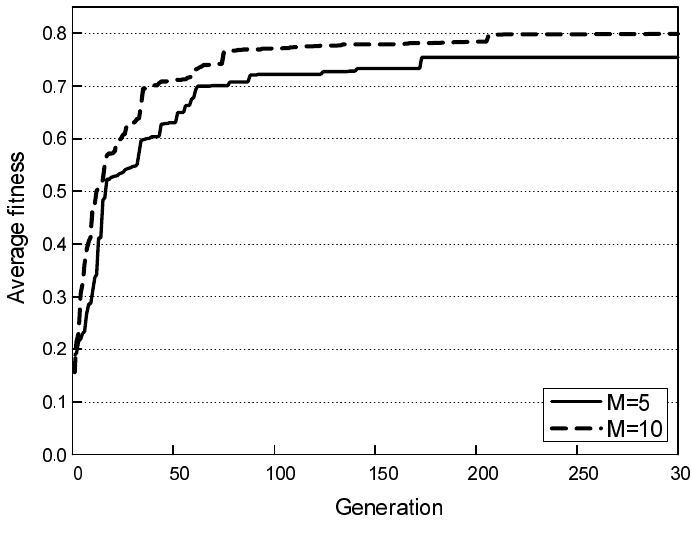
Figure 7. Evolution process of average fitness for ten runs of our genetic